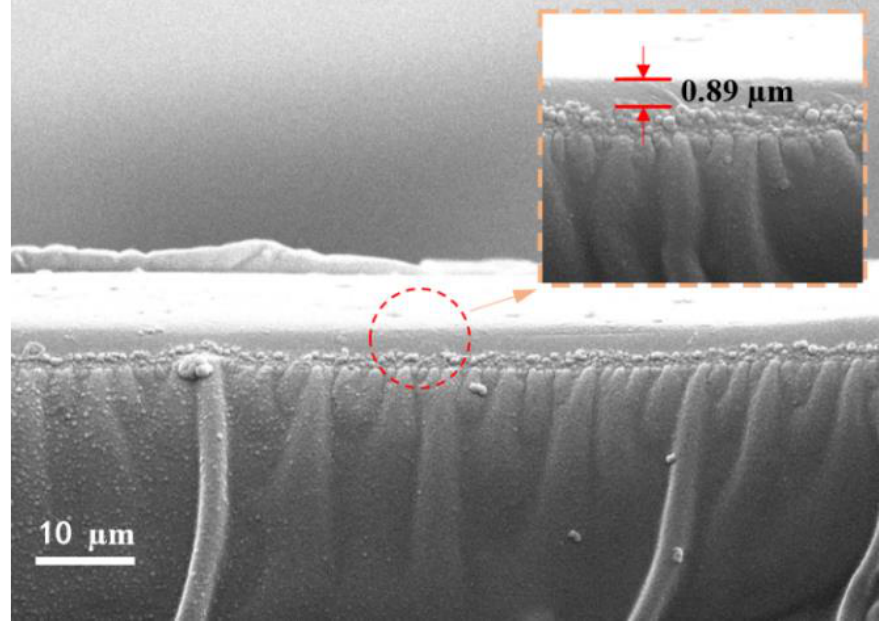
Figure 8. SEM of IP − ZrO 2 /BC − NFM cross − section.